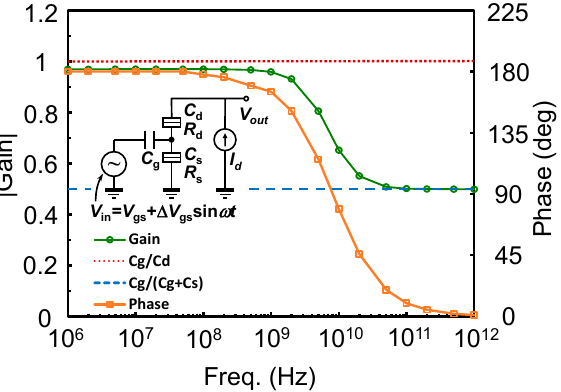
Figure 8. Frequency response of the SET inverting amplifier operating at a drain current I d = 26.4 pA, gate voltage V gs = 53.4 mV [0.33] (center of the descending side of the CD) and T = 15.5 K [0.05]. The input capacitance C gg is also simulated as a function of the gate voltage V gs at three different frequencies and shown in Figure 9.